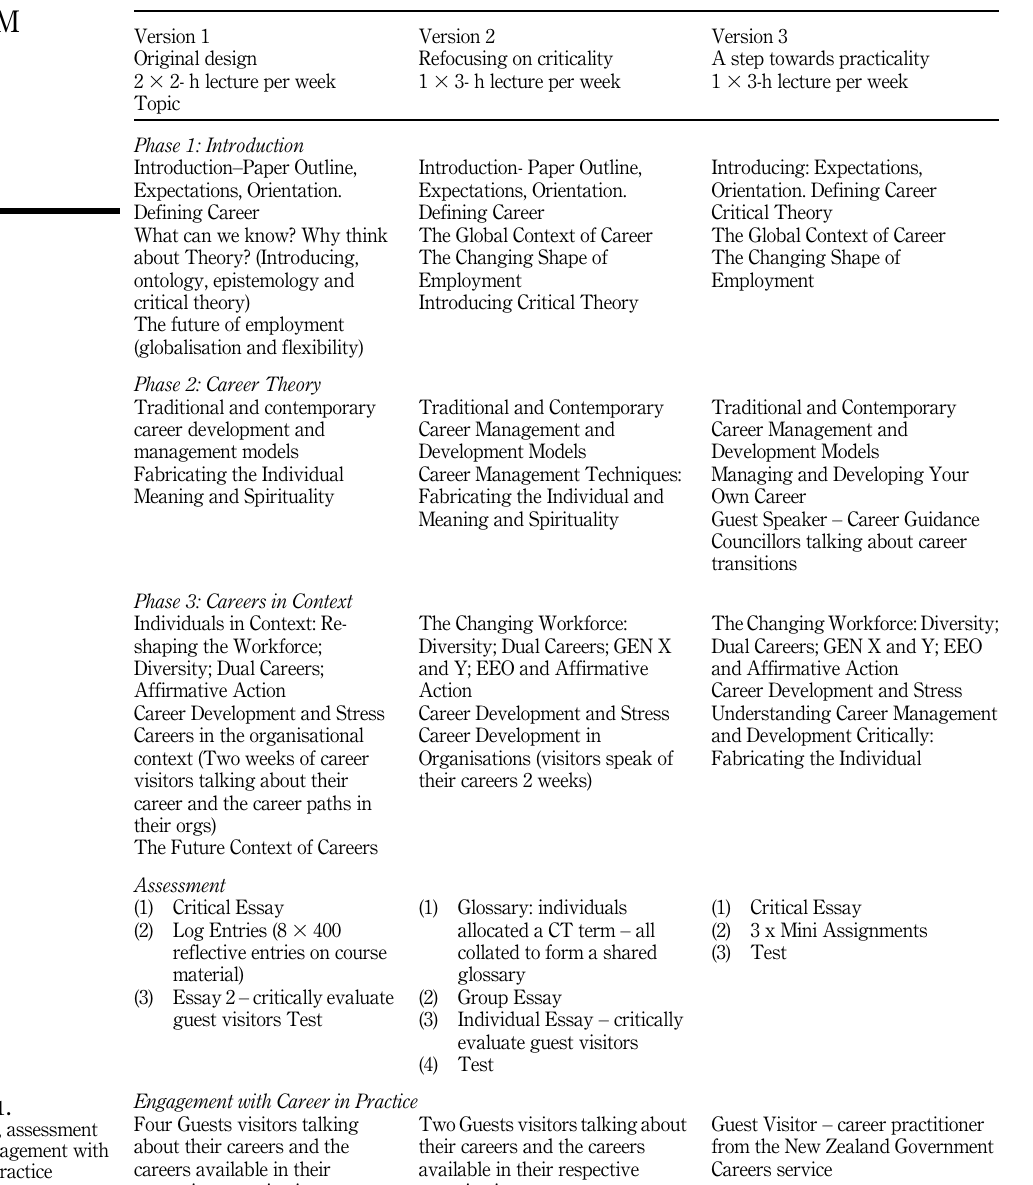
Table 1. Content, assessment and engagement with career